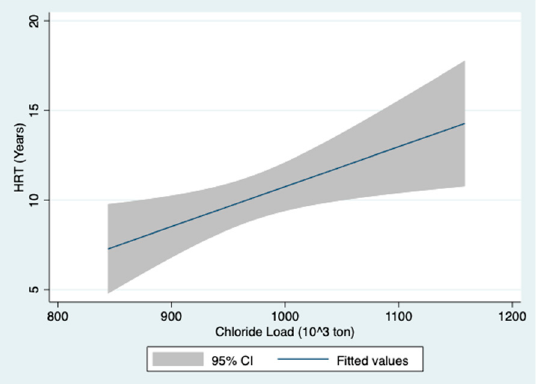
Figure 22. Linear regression (95% CI) between annual means (1970–2020) of Hydraulic residence time (HRT) (Years) and salt load (10 3 tons).